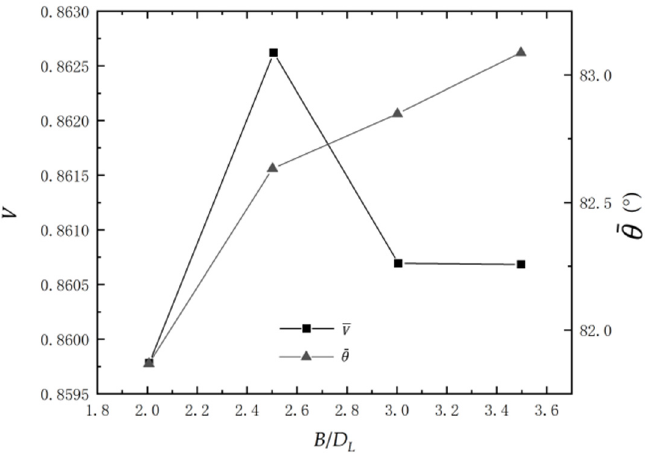
Figure 14. Velocity uniformity and weighted average angle of outlet velocity curve with different